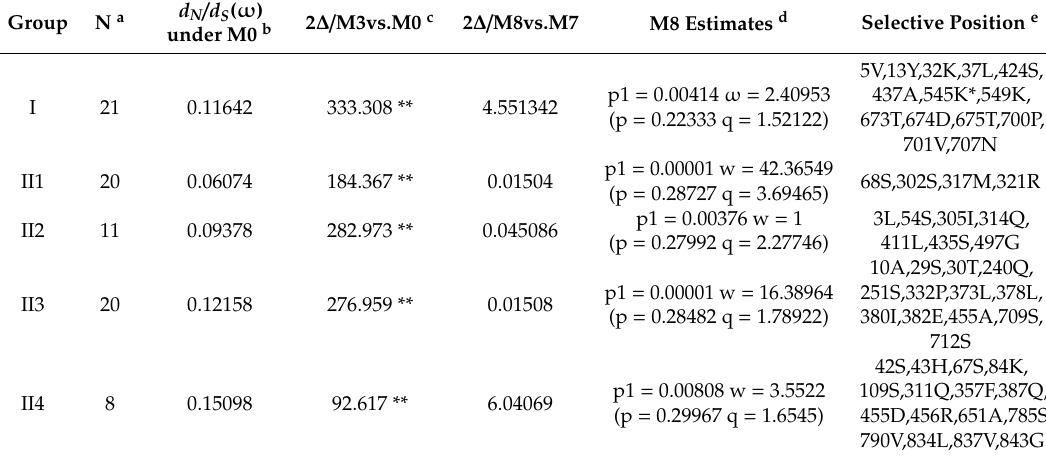
Table 1. Detection selective pressure of the TPS family under site models.